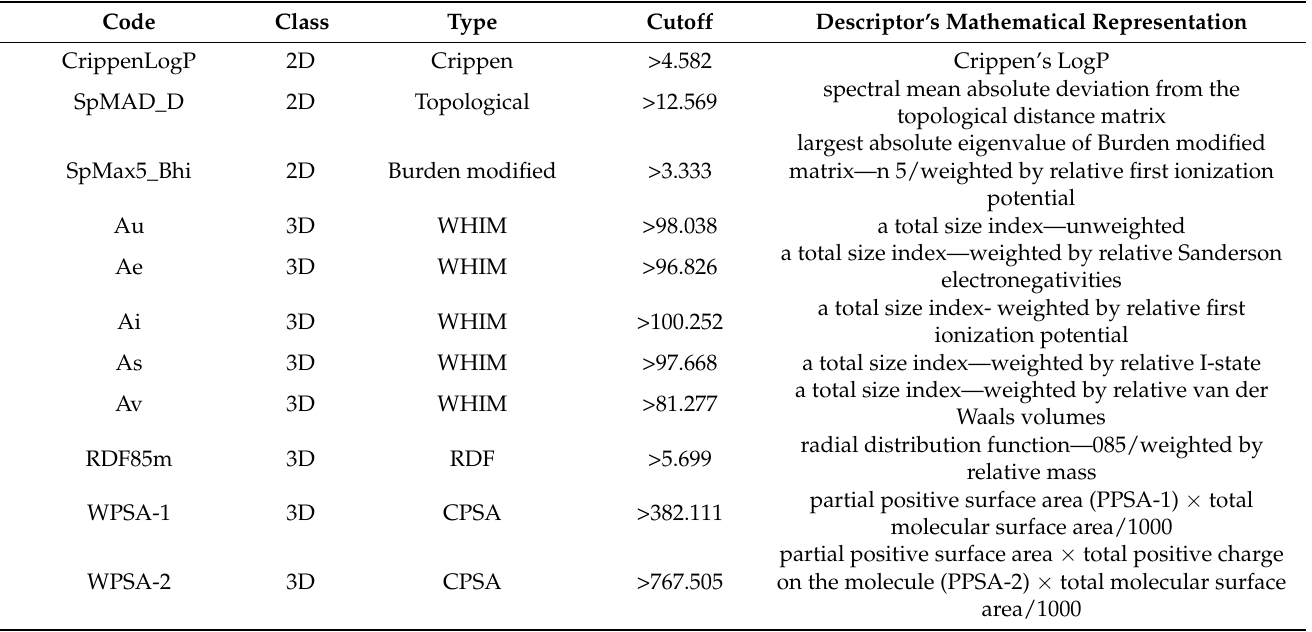
Table 2. List of molecular descriptors with significantly different values in relation to strong and weak FAAH inhibitors. The cutoff value indicates the threshold for discriminating strong FAAH inhibitors.